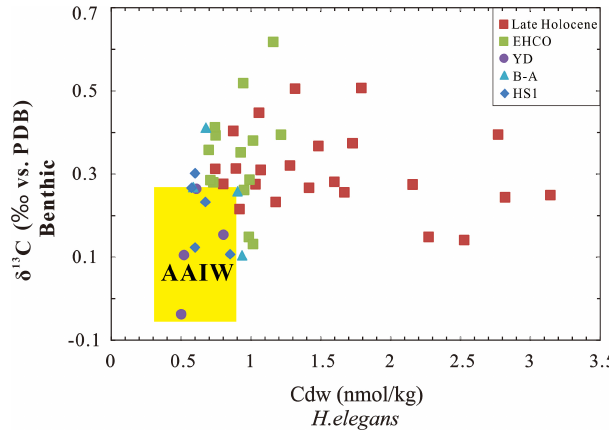
Figure 7. Intermediate Cd w versus benthic δ 13 C obtained from core MD77-191 located off the southern tip of India. The yellow shaded area represents the ranges of Cd w – δ 13 C values of AAIW during the HS1 and YD, which were reconstructed in the Indian Ocean (benthic δ 13 C, Naqvi et al., 1994; Jung et al., 2009; Ma et al., 2019, 2020) and the Pacific and Atlantic oceans (benthic Cd w , Valley et al., 2017; Umling et al., 2018) at intermediate water depths. The abbreviations are the same as in Fig.